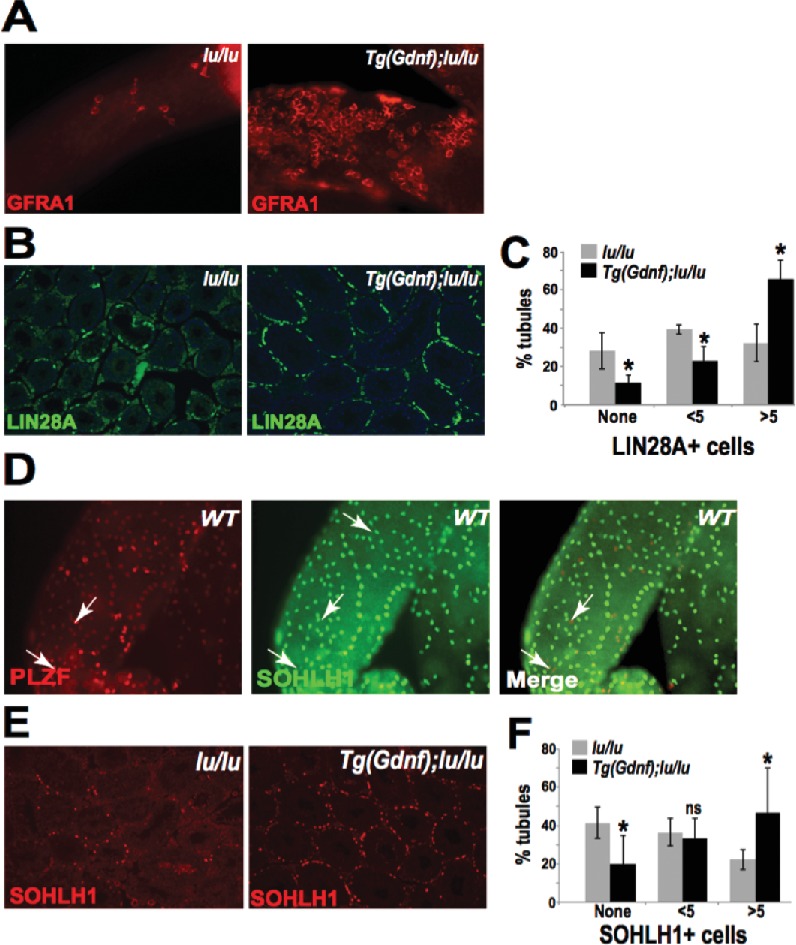
Sertoli-cell overexpression of GDNF increases the SSC population in Plzf-mutant luxoid mice.(A) Immunostained whole-mount tubules from 12-week old Tg(Gdnf);lu/lu mice show large clusters of GFRA1+ cells compared to lu/lu. (B) Representative LIN28A immunostaining of lu/lu and Tg(Gdnf);lu/lu tubule paraffin sections. (C) Quantification of immunostained sections as in (B) show 70% more tubules with 5 or more LIN28A+ cells in Tg(Gdnf);lu/lu compared to lu/lu (n=4). *, p < 0.05. (D) In WT, SOHOLH1 expression is detected in Aal cells transitioning to A1 and differentiating cells A2-A4, absent from As , Apr , and Aal cells. (E) Representative SOHLH1 immunostaining of lu/lu and Tg(Gdnf);lu/lu tubule paraffin sections. (F) Quantification of immunostained sections as in (E) show a significant increase in the number of tubules with 5 or more SOHLH1+ cells in Tg(Gdnf);lu/lu compared to lu/lu. (n=4). * p<0.05, ns, not significant.10.7554/eLife.43352.004Figure 1—figure supplement 1—source data 1.Source file for Figure 1—figure supplement 1C and 1F.